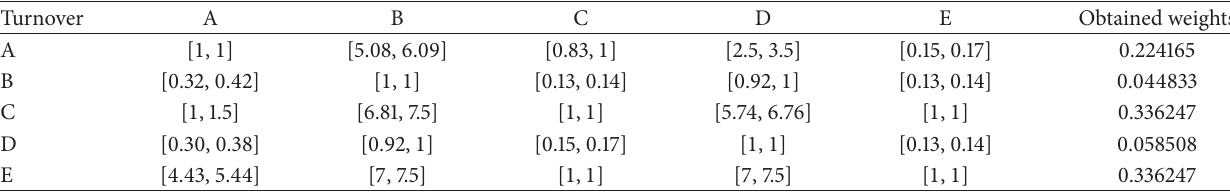
Table 18: The interval approximation choices referring to turnover